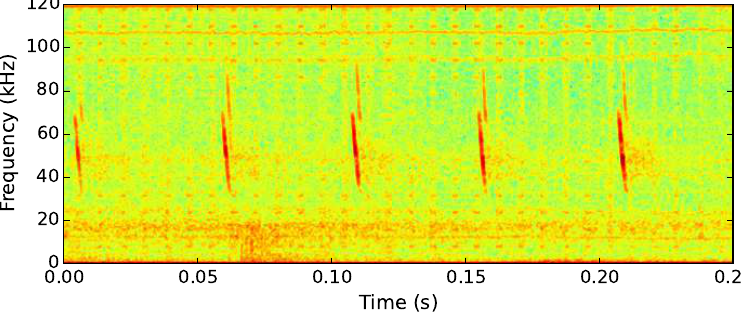
Figure 6. Spectrogram showing the first target sound: echolocation calls of a soprano pipistrelle